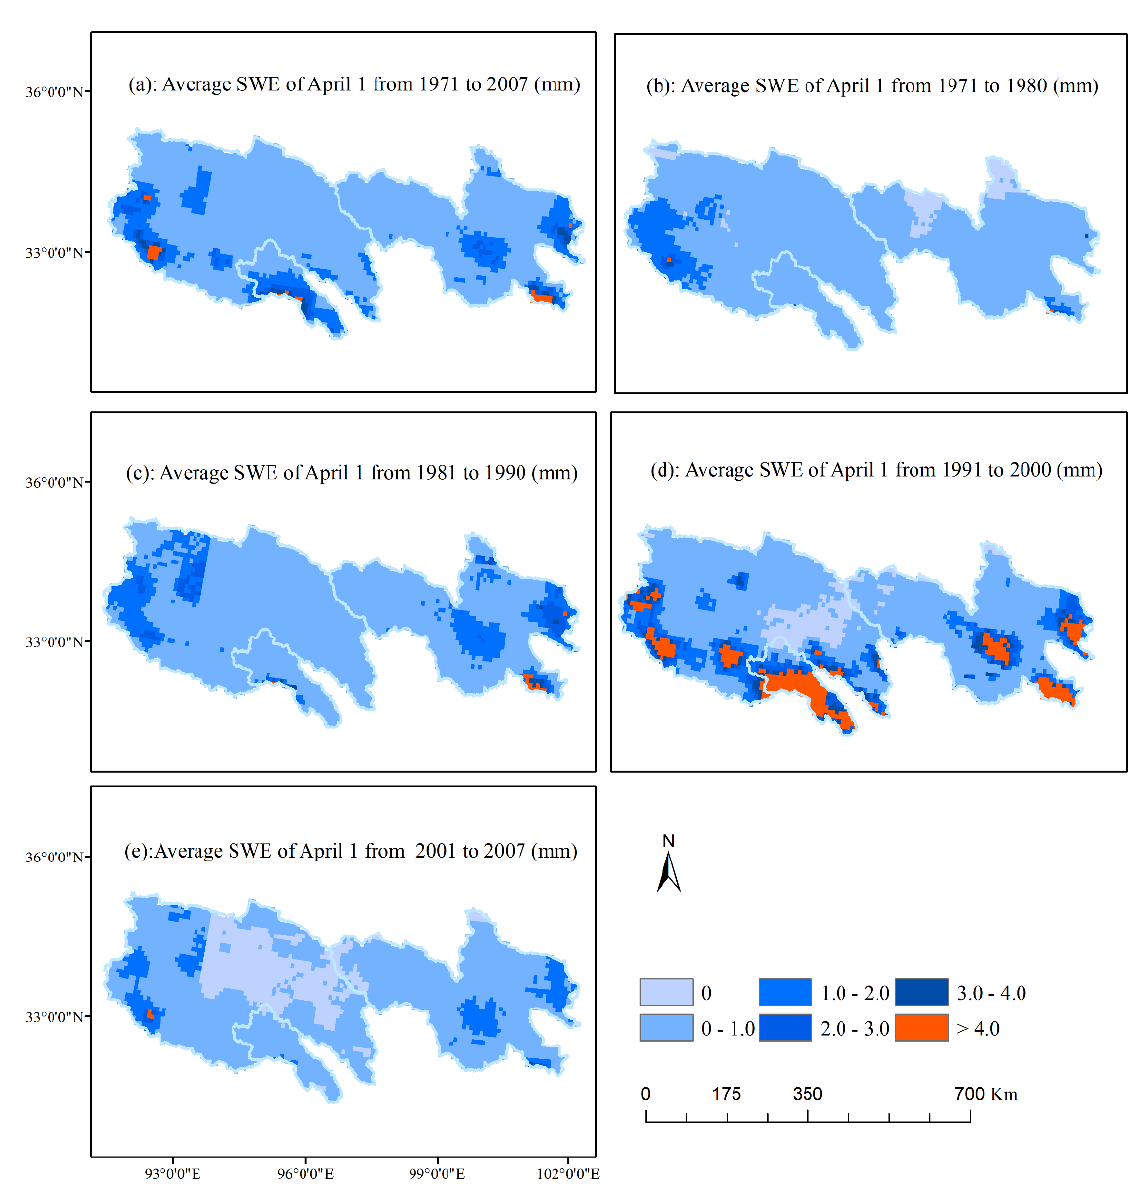
information for the evaluation of terrestrial water storage and has significant implications for water resource managers.